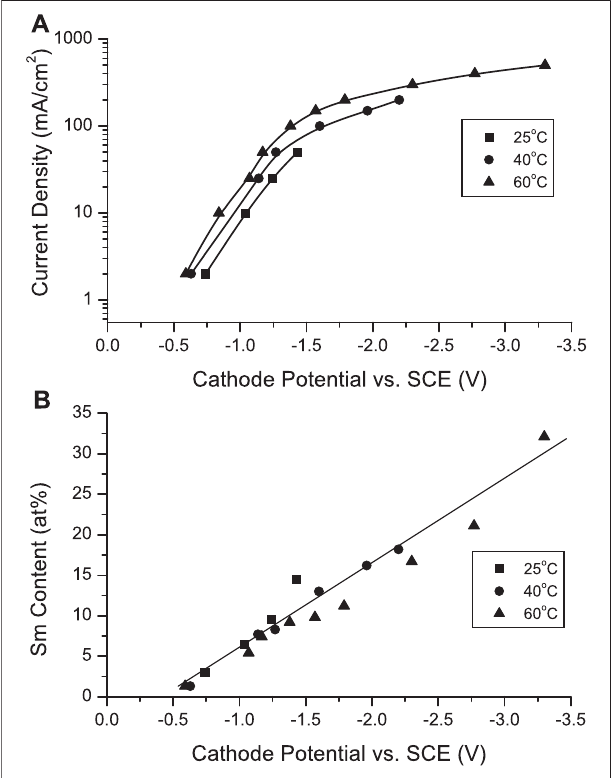
FIGURE 2 | (A) Cathodic polarization curves in the electrodeposition of Sm-Co alloys at various current densities and solution temperature and (B) dependence of Sm content on cathodic